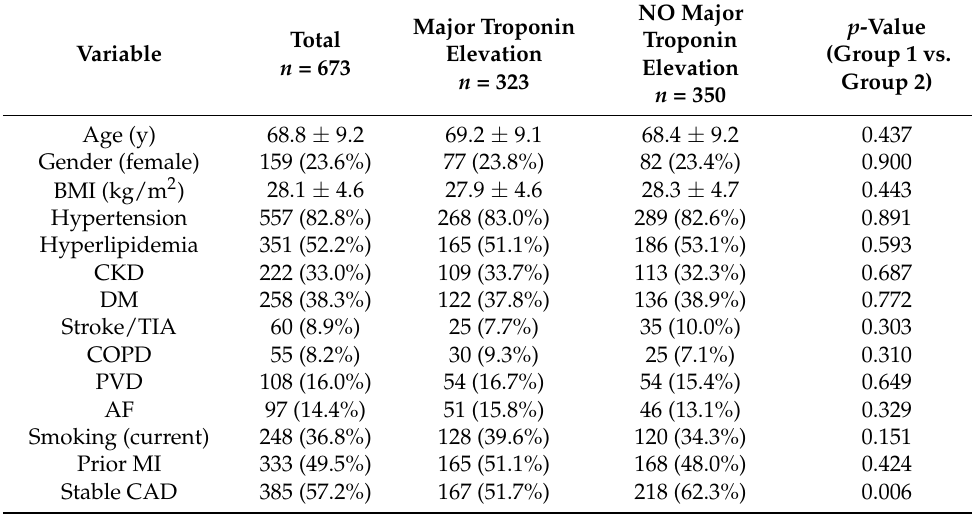
Table 2. Baseline characteristics by treatment